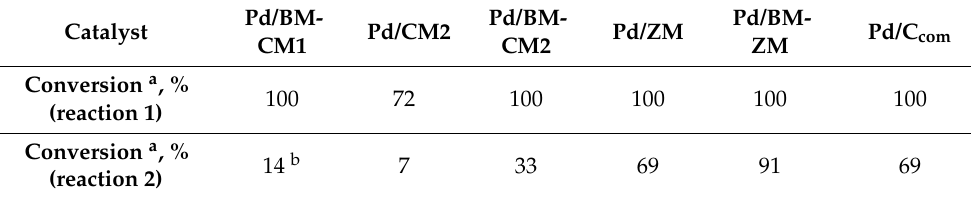
Table 2. Cross-coupling reactions in the presence of prepared catalysts.